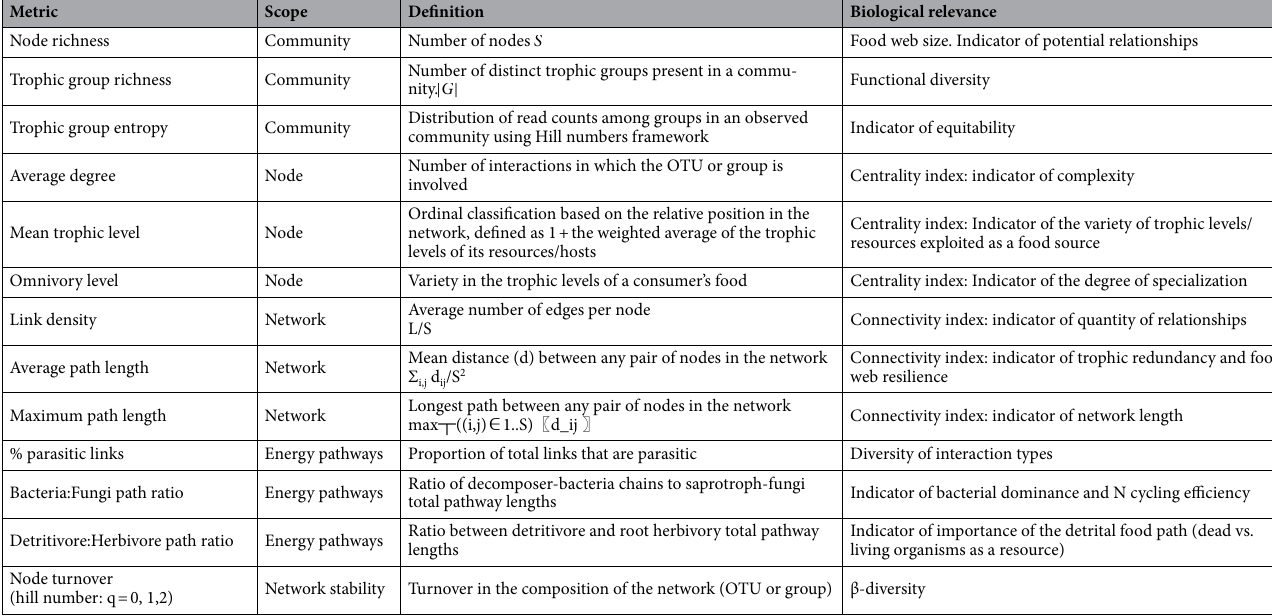
Table 2. Network metrics applied at experimental fields to assess soil biodiversity, trophic complexity and energy pathways of the soil food web 63,64 . The interaction network is described by nodes (N), which are either OTUs or trophic groups (G), and edges (L, links from a resource node to a consumer node). Edges are described by their type (predator, parasitic, symbiotic), and weighted by the probability of occurrence of the resource and consumer